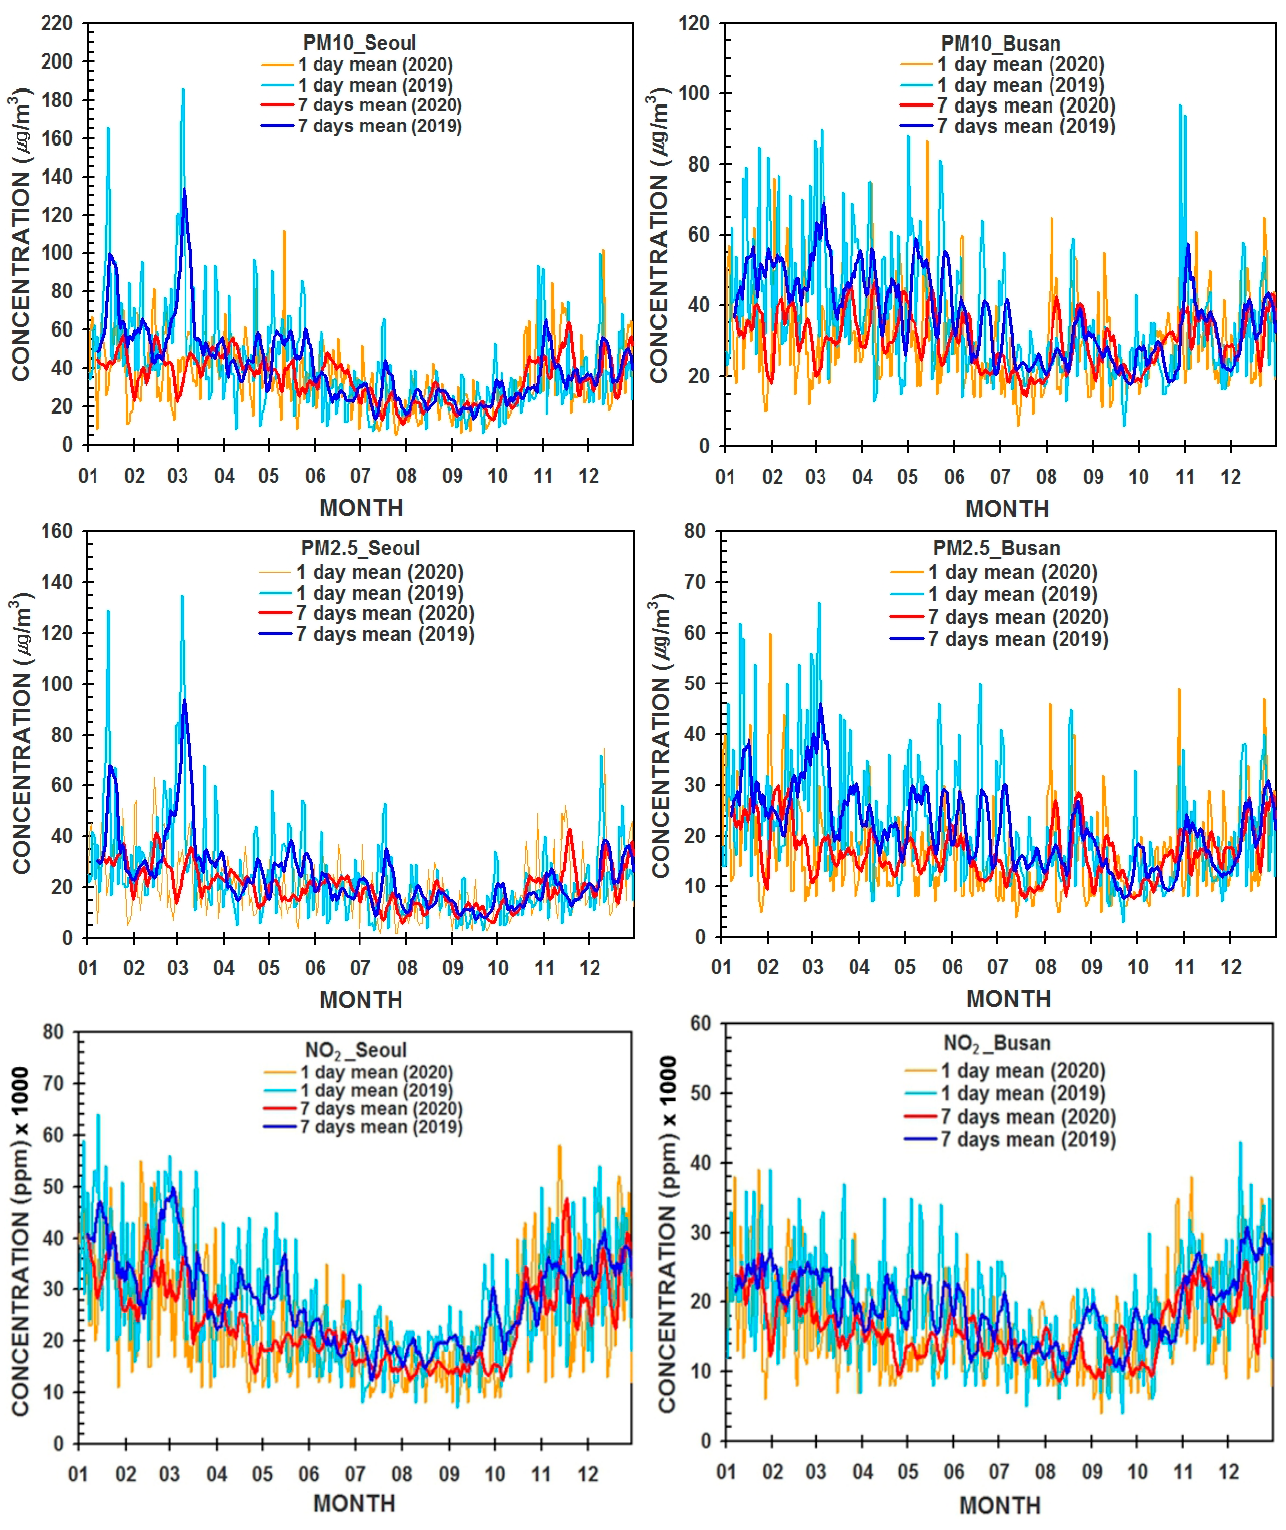
Figure 3. Temporal variations of measured daily and seven days averaged concentrations of PM 10 ( μ g/m 3 ), PM 2.5 ( μ g/m 3 ), and NO 2 (ppm × 1000) before (2019) and during the COVID-19 epidemic year (2020) in Seoul and Busan cities, Korea. Weekly mean values of PM 10 , PM 2.5 , and NO 2 concentrations in Seoul have similar tendencies to their daily mean values in 2019 and 2020 in Seoul and Busan. Daily and weekly mean concentrations of NO 2 in 2020 have slightly decreased by about 15%